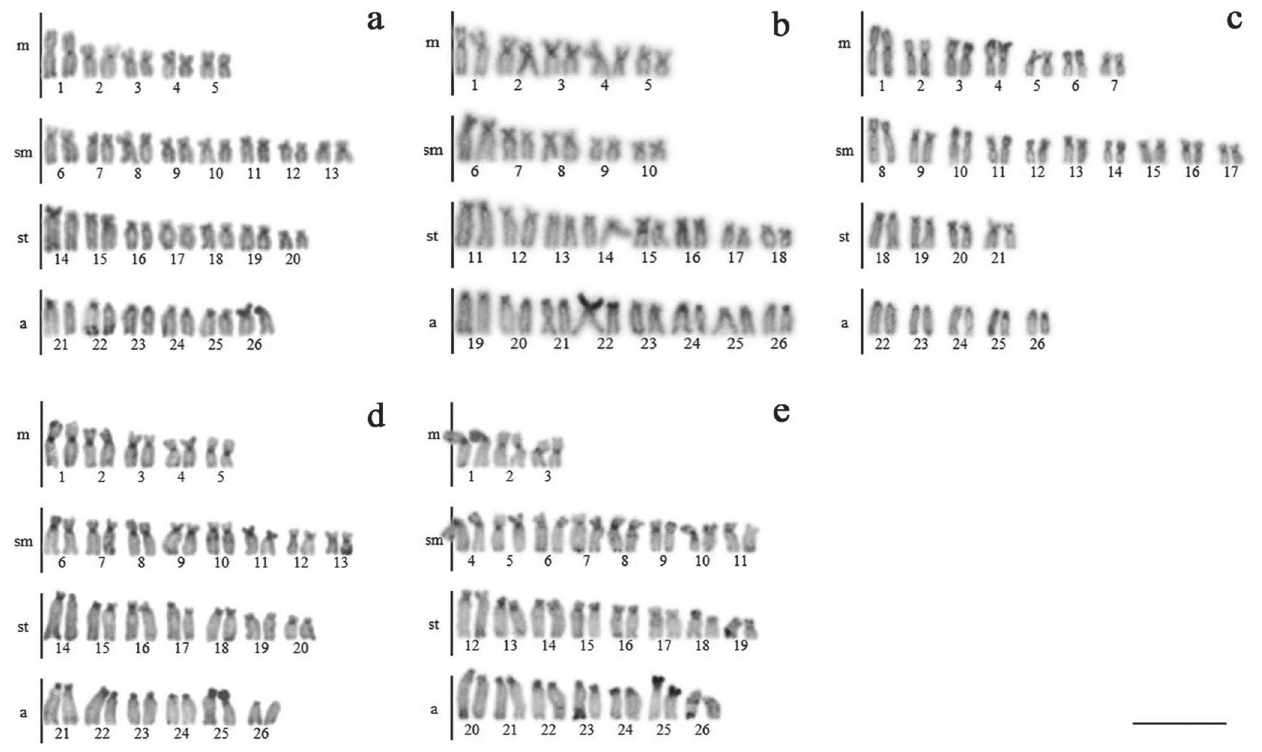
Fig. 2. Karyotypes arranged from C-banded chromosomes. a. Bryconamericus aff. iheringii (Ijuí River, pattern II); b. B. aff. iheringii (Iguaçu River); c. B. coeruleus (pattern II); d. B. cf. ecai ; e. B. cf. eigenmanni . Scales bar = 10 μm.